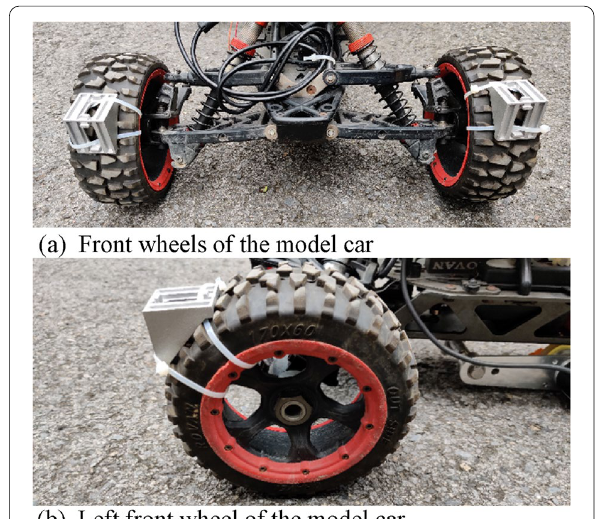
Figure 8 Wheels of the model